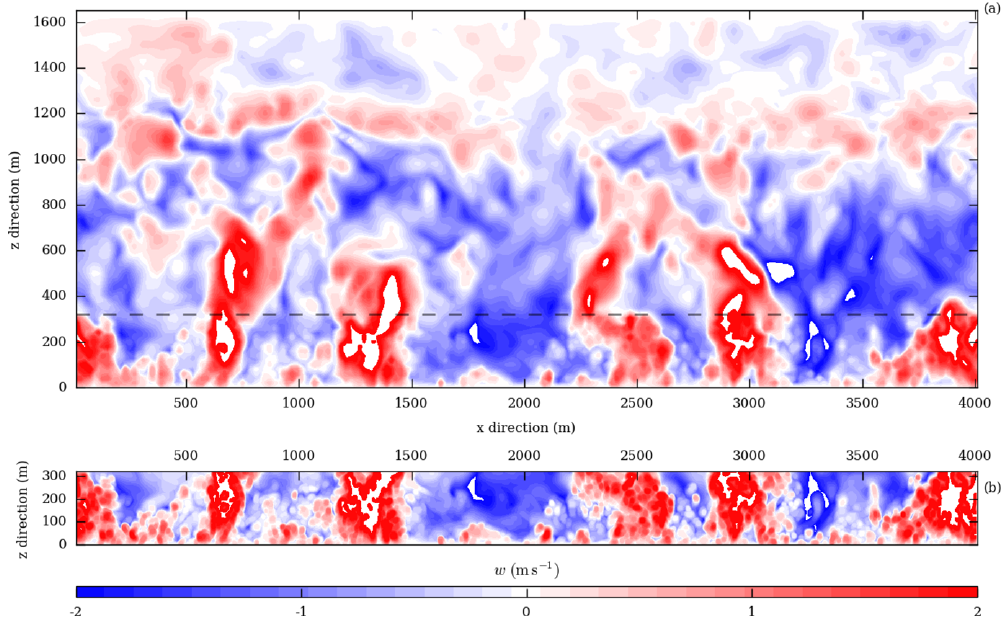
Figure 4. Instantaneous contours of vertical velocity, (a) CG and (b) FG, at the vertical x − z cross section at the center of the domain after 10800s of the simulation. The dashed line in (a) marks the top of the overlapping region. Flow structures in the FG, which are similar but more detailed than the CG, qualitatively indicate the improvement to the surface layer resolution with the two-way nesting.